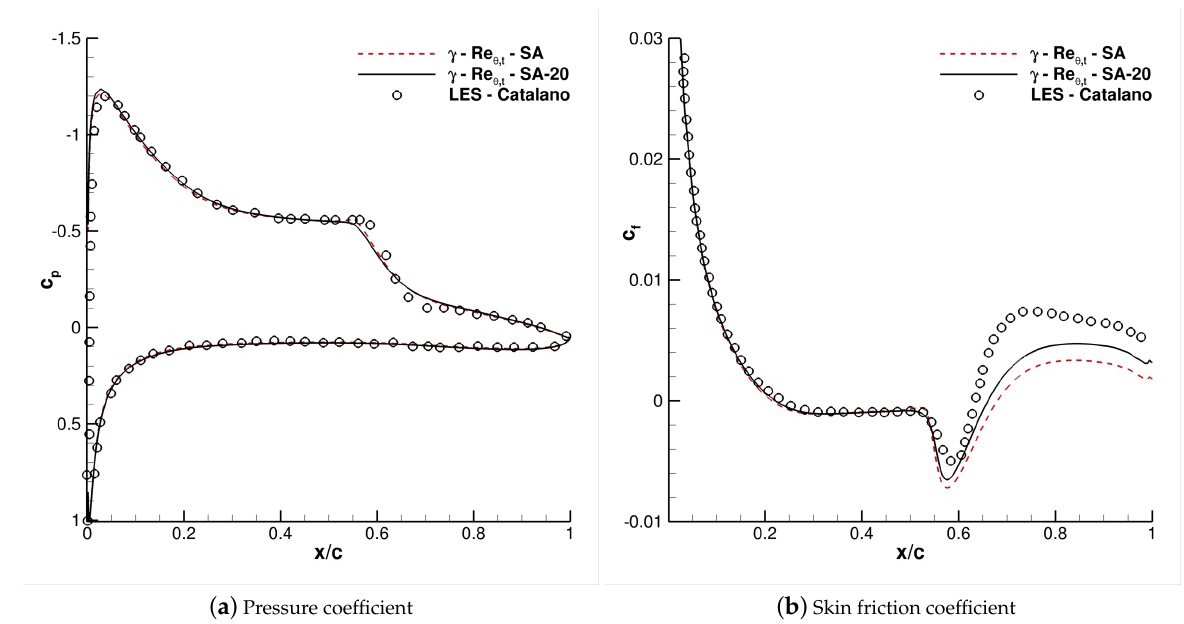
Figure 1. SD7003, Re = 6 × 10 4 . α = 4 ◦ .